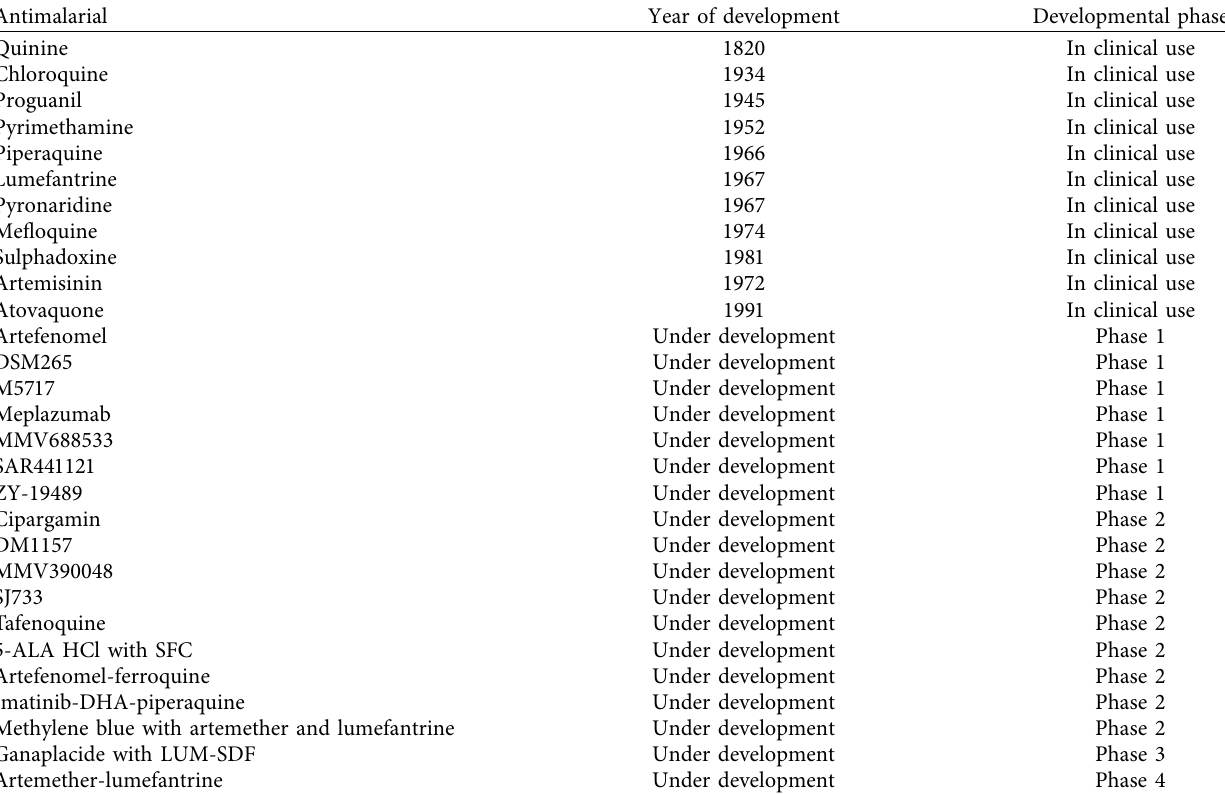
Table 1: Important antimalarial drugs and their developmental